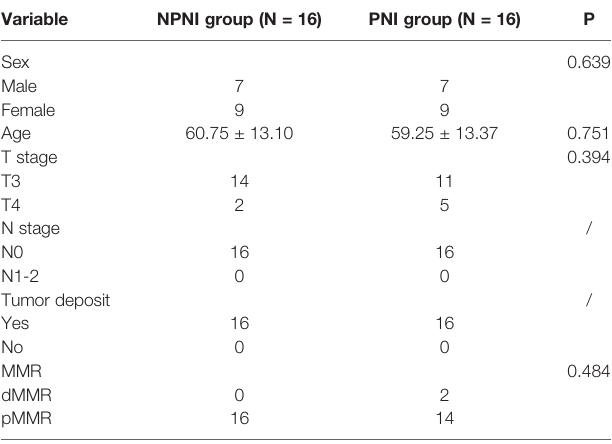
TABLE 1 | Baseline characteristics of the